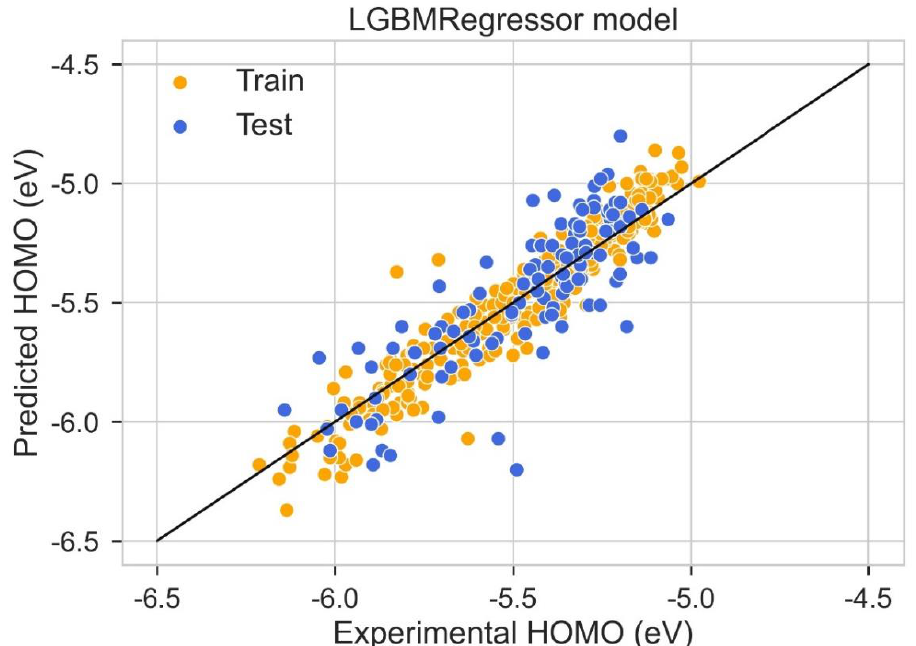
Figure 7. Scatter plot between experimental and predicted HOMO using LGBM regression model.